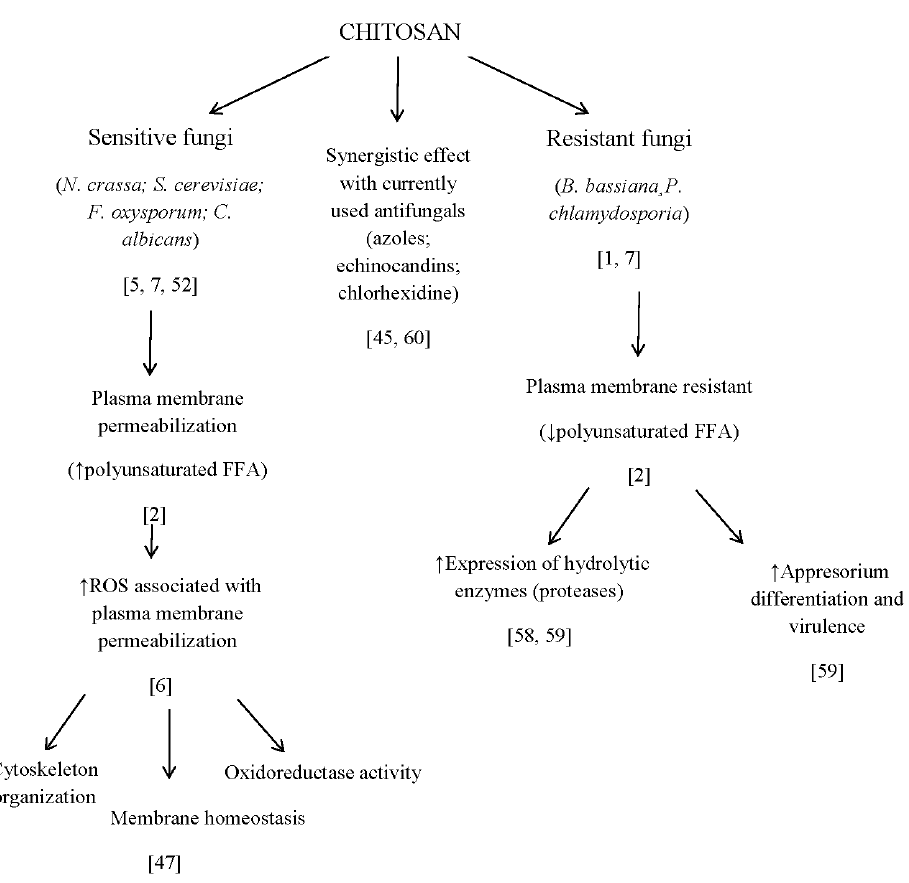
Figure 4. Conceptual diagram of chitosan as an antifungal and gene modulator.